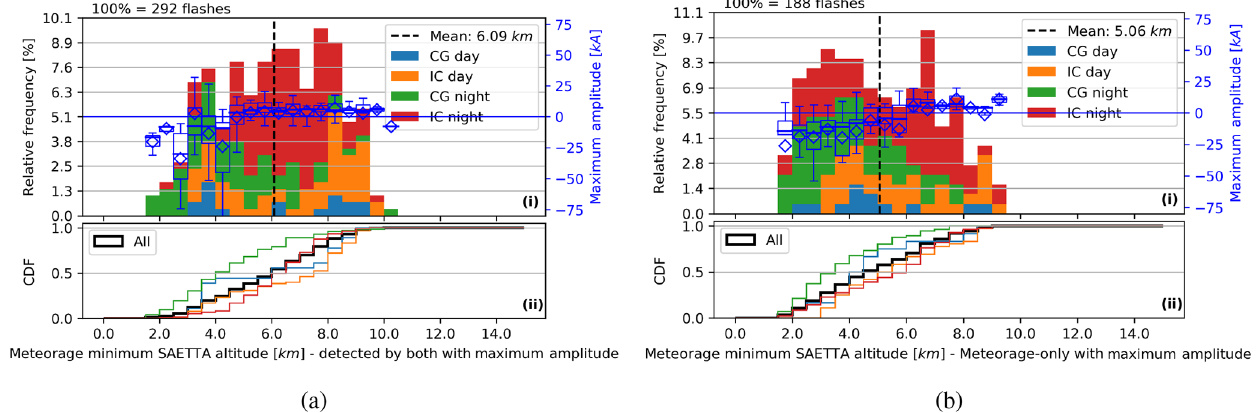
Figure 15. As Fig. 14 for the minimum altitude of Meteorage flashes with (a) and without (b) a match. Here, the blue box plots represent the distributions of the Meteorage maximum (pulse–stroke) amplitude per flash (positive or negative currents) for each altitude